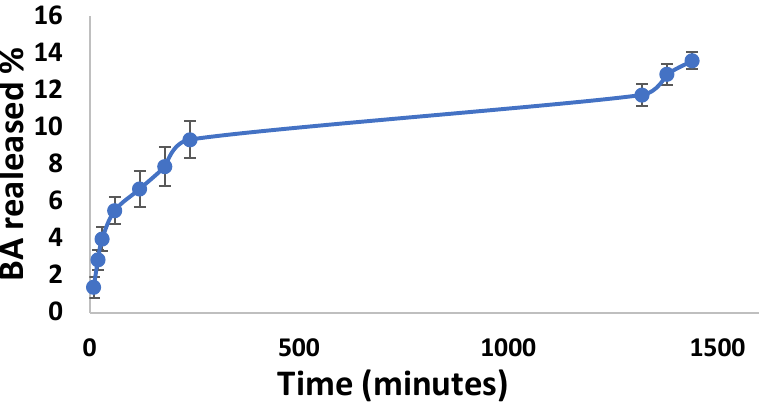
Figure 3. Graphical representation of the BA release from BC4 fibers at different moments (10, 20, 30 min and 1, 2, 3, 4, 24, 25, 26 h).